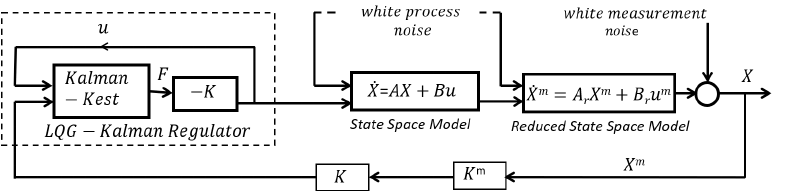
Figure 3. A schematic representation corresponding to the reduced model of LQG-Kalman